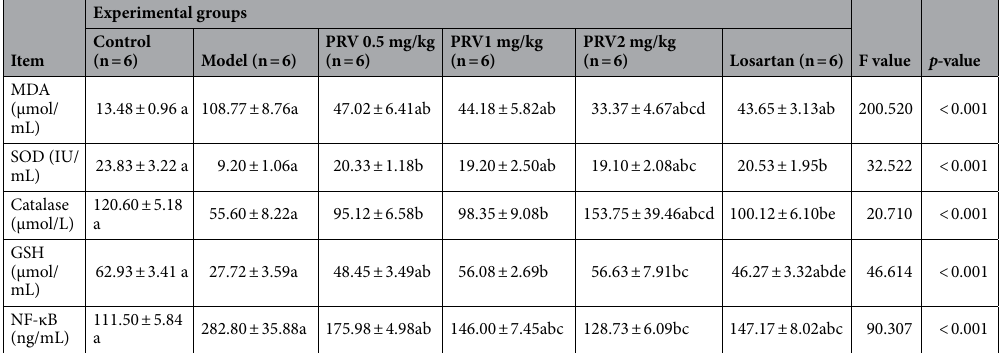
Table 4. Mean ± SD for biochemical analysis of serum oxidative stress biomarkers and NF-κB in different experimental groups. The results are presented as the means ± standard deviation (SD). The groups with different superscripts in the same row represent a statistical significance ( p < 0.05), a: control group; b: model (dexamethasone-treated) group; c: PRV 0.5 mg/kg group; d: PRV1mg/kg group; e: PRV 2 mg/kg group. n number/group, PRV propolis, royal jelly & bee venom, MDA malonaldehyde, SOD superoxide dismutase, GSH reduced glutathione, NF-κB nuclear factor kappa-light-chain-enhancer of activated B